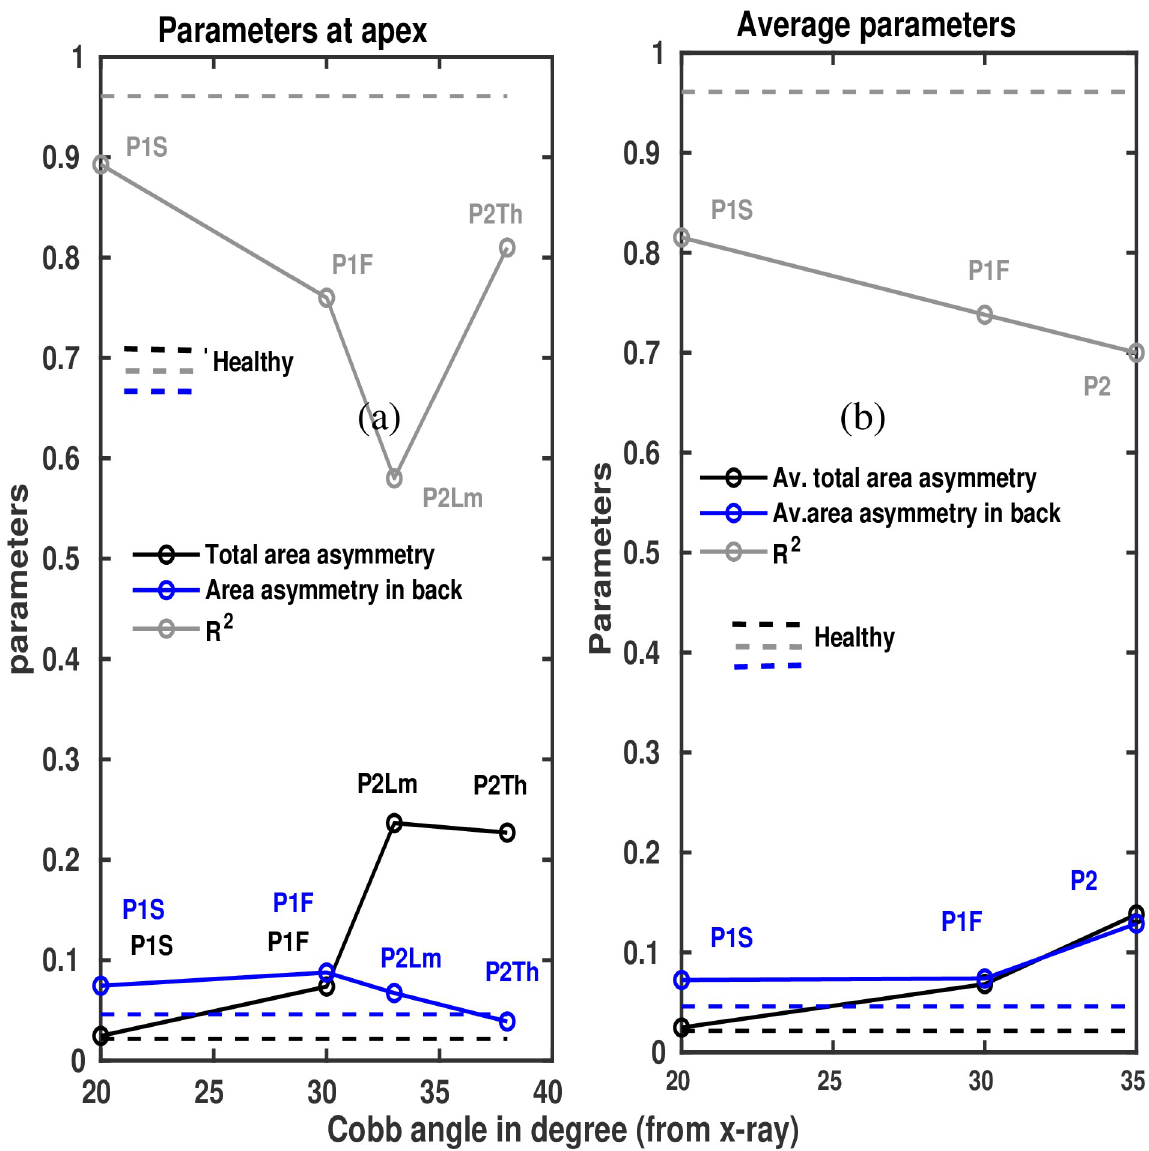
Fig 6. Asymmetry parameters vs Cobb angle. (a) Obtained asymmetry parameters are plotted against extracted Cobb angles for the cases analyzed here. Lines with symbols represent the values in patients. Dashed lines indicate the healthy case. Different colours indicates different parameters. P1F indicates the value of the parameter for P1 at first scan, P1S indicates the value of the parameter for P1 at second scan, P2Th indicates the same for P2 at thoracal region, P2Lm the same at lumber region. (a) Represents the values at apex, (b) average values from different vertebral